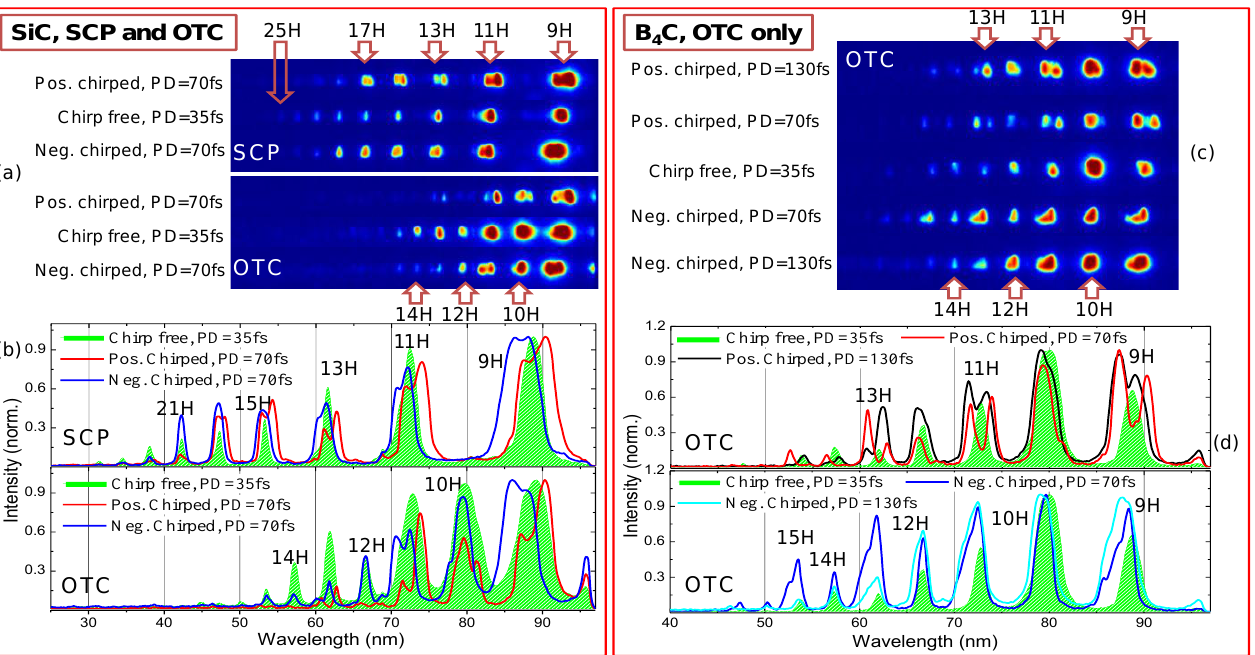
Figure 7. HHG for SiC and B 4 C NP LIPs with chirped and chirp-free SCP and OTC. Panel ( a , c ) show raw MCP images for SCP and OTC using 0.2 mm thick BBO crystal. Panel ( c ) presents only OTC for B 4 C LIP. Panels ( b , d ) present profiles plots for corresponding images.